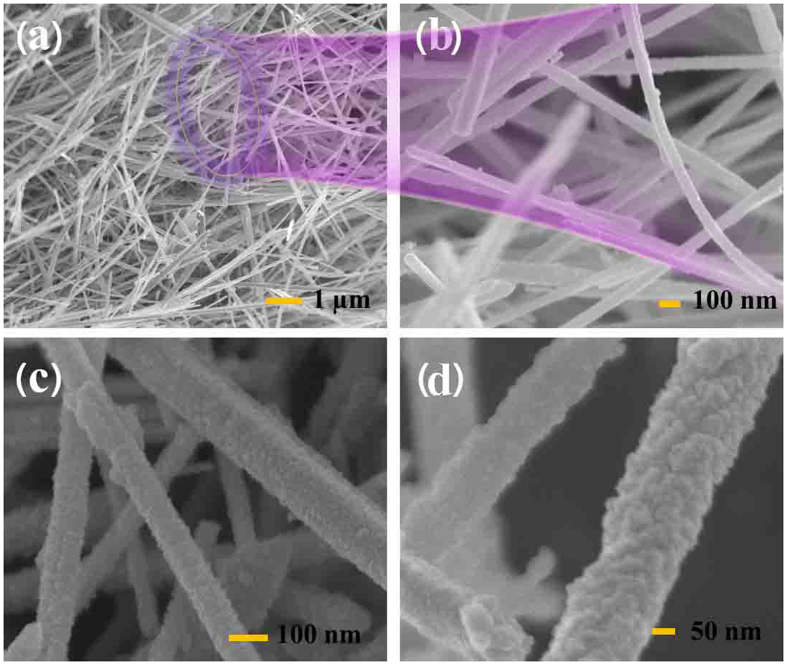
(a,b) The low and high magnified SEM images of the pristine ZnO NWs, SEM images of (c) ZnSn(OH)6/ZnO composite and (d) SnO2/ZnO heterojunction.